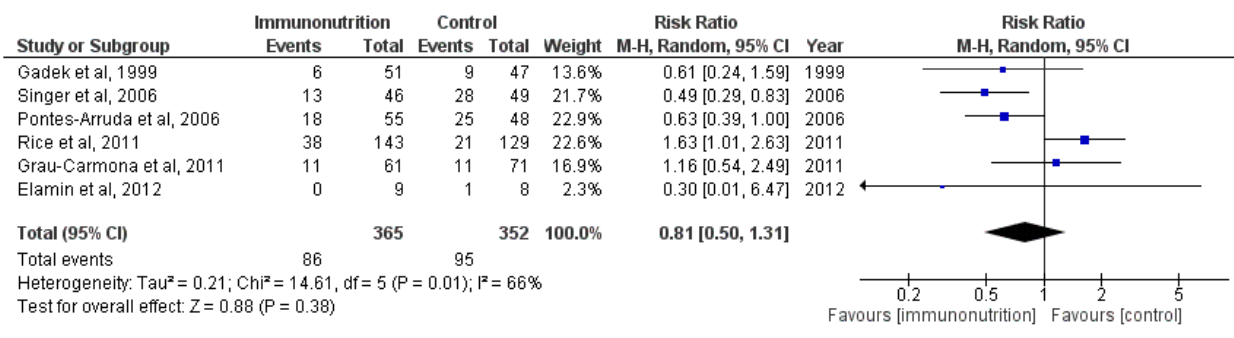
Figure 2. Forest plot of the association between enteral immunomodulatory diet and all-cause mortality among patients with ALI (acute lung injury)/ARDS (acute respiratory distress syndrome).